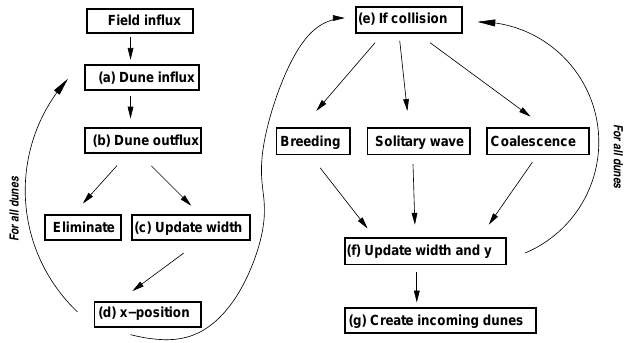
Fig. 8. The model for barchan dune fields. Illustration of the set of operations executed at each time step.